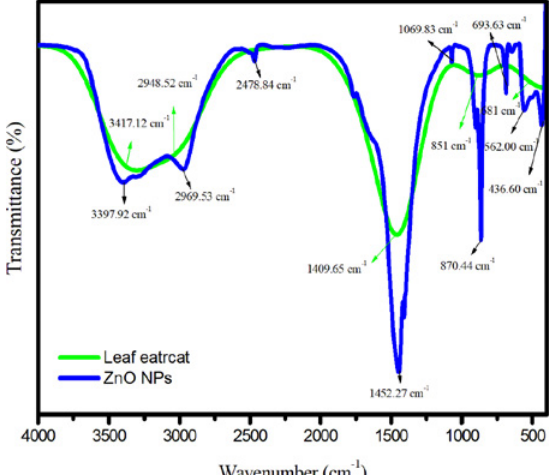
Fig. 6. FT-IR spectra of Acalypha indica leaf extract and biosynthesized ZnO